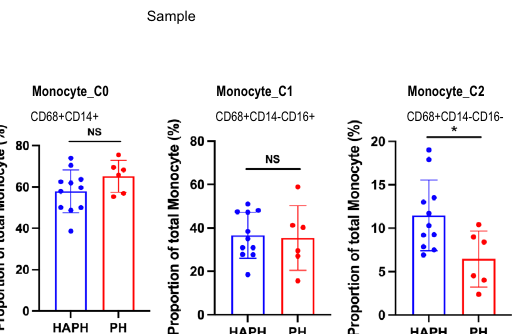
shown. d Proportions of each cell type in each sample as indicated. ( e – g ) The proportion of T cells, NK cells and C0, C1, C2 monocyte subsets in PBMCs from HAPH ( n =11) and PH ( n =6) patients as analyzed by fl ow cytometry (* p <0.05; Unpaired t testwasu t ilized asappropriate.Data werepresentedasmean±SD). PH pulmonary hypertension, HAPH high-altitude pulmonary hypertension, t-SNE t- distributed stochastic neighbor embedding, PBMCs peripheral blood mononuclear